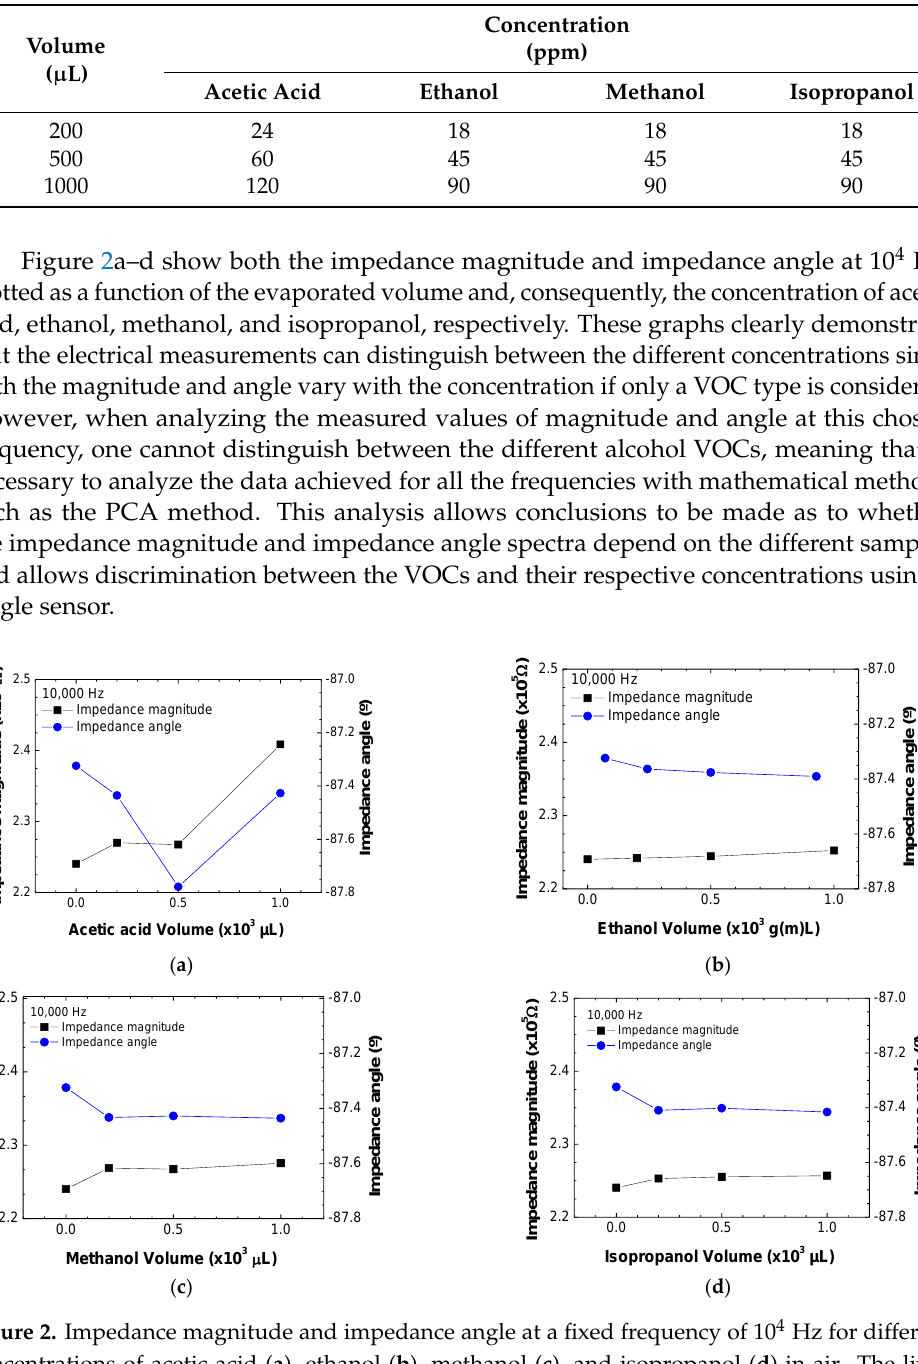
Table 1. Evaporated volumes ( µ L) and respective concentration levels (ppm) for the four considered VOCs; acetic acid, ethanol, methanol, and isopropanol.